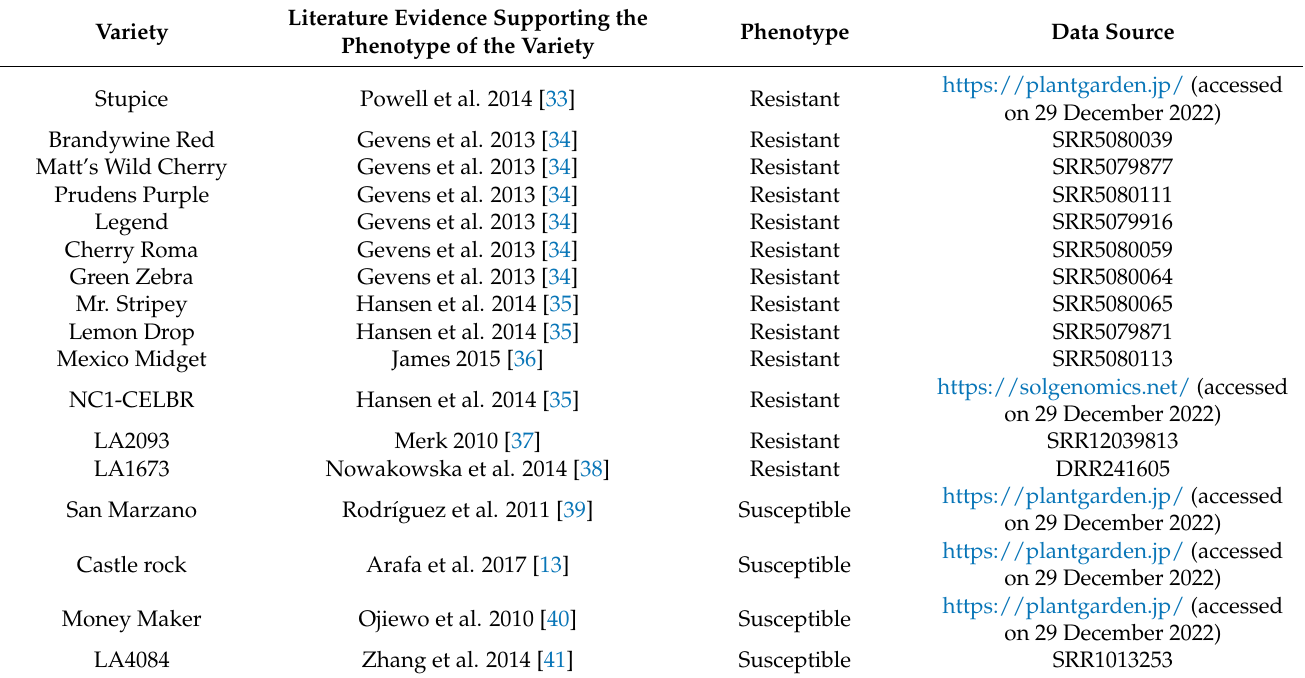
Table 2. List of public datasets used in the